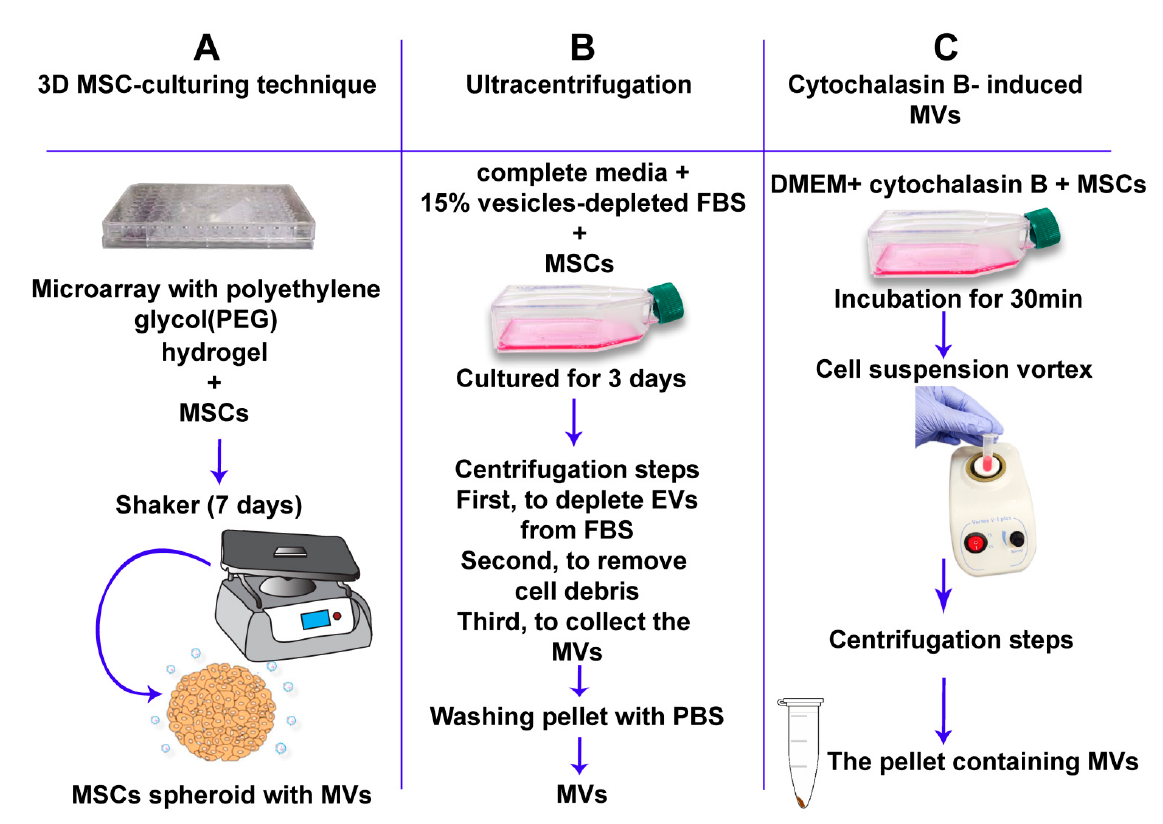
Figure 2. Formation of artificial MVs. Three separate approaches for the artificial formation of MVs. ( A ) The 3D mesenchy- mal stem cell (MSC)-culturing technique uses polyethylene glycol hydrogels to form spheroid MSCs. MSC-spheroids are subsequently cultured for 7 days on a 30-rpm orbital-shaker (3D w/shaking). Scalable pro-duction of MSC-derived MVs can be achieved by this method. ( B ) The ultracentrifugation approach. This includes numerous centrifugation steps. MSCs are first cultured with complete media supplemented with 15% vesicle-depleted fetal bovine serum (FBS) for 3 days. MSCs are then centrifuged at 120,000 × g for 18 h to deplete extra-cellular vesicles from FBS. The cell solution is centrifuged at 300 × g for 30 min at 4 ◦ C to remove whole cells and large debris. Supernatants are then centrifuged at 16,500 × g for 20 min at 4 ◦ C to collect the MV fraction [149]. (C) Cytochalasin B-induced MVs. This approach depends on the incubation of MSCs with cytochalasin-B to obtain MVs.